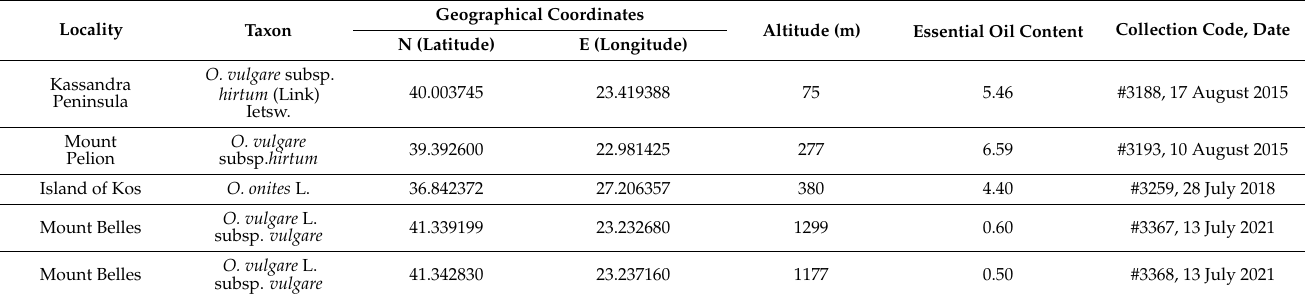
Table 1. Collection localities of wild-growing Origanum plants, geographical coordinates, altitude (m), essential oil content (mL/100 g dry weight) and collection code and